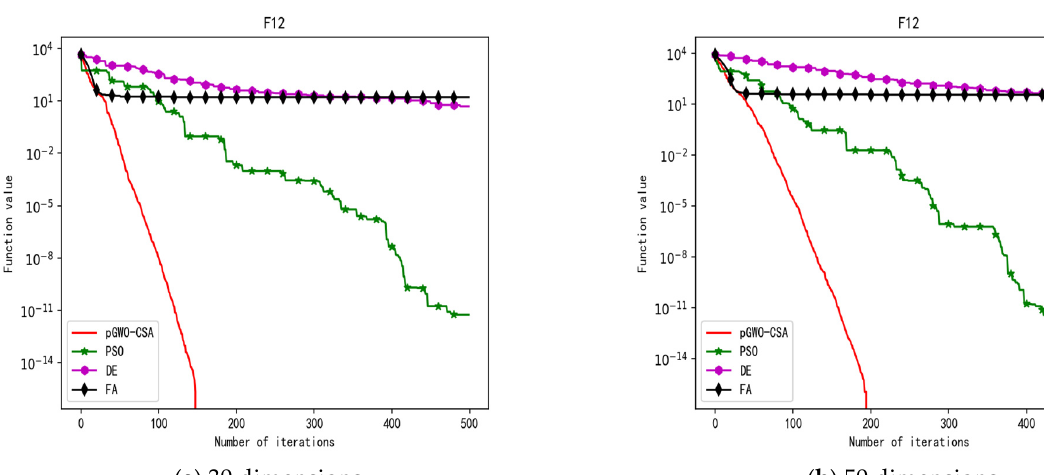
Figure 16. Convergence curve of test function F12.